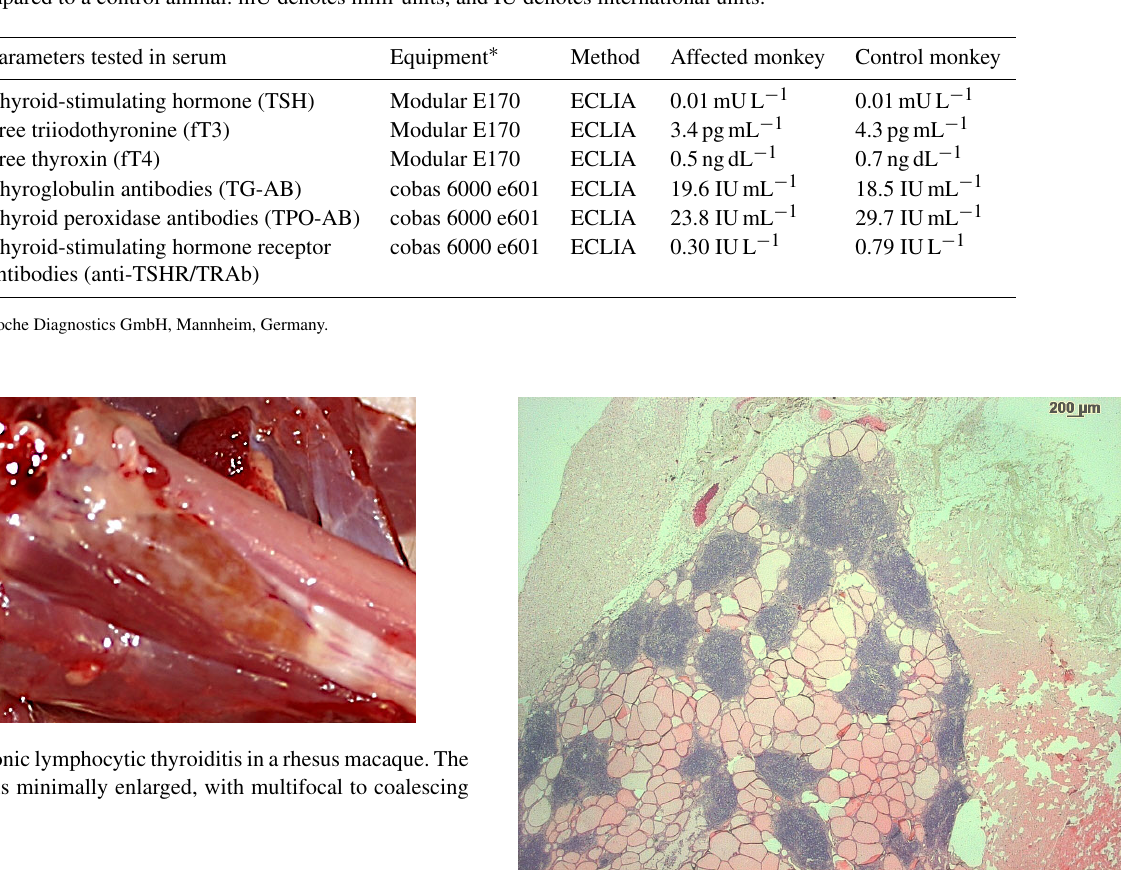
Table 1. Electrochemiluminescence immunoassay (ECLIA) thyroid parameters in a rhesus macaque with spontaneous chronic lymphocytic thyroiditis compared to a control animal. mU denotes milli-units, and IU denotes international units.